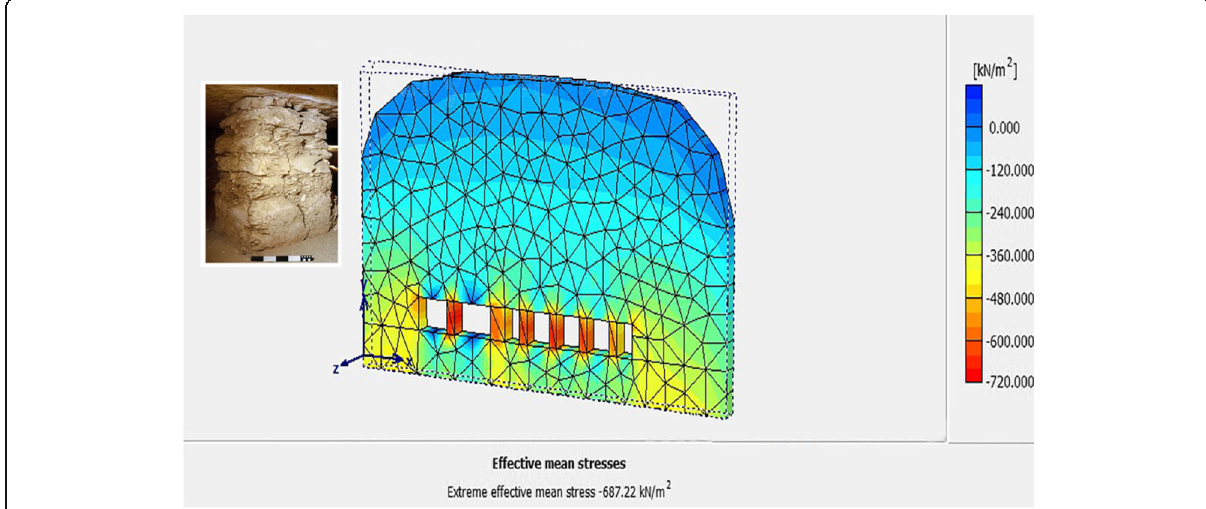
Fig. 21 Effective mean stresses distribution through the rock pillars in Chamber 3. PLAXIS 3D